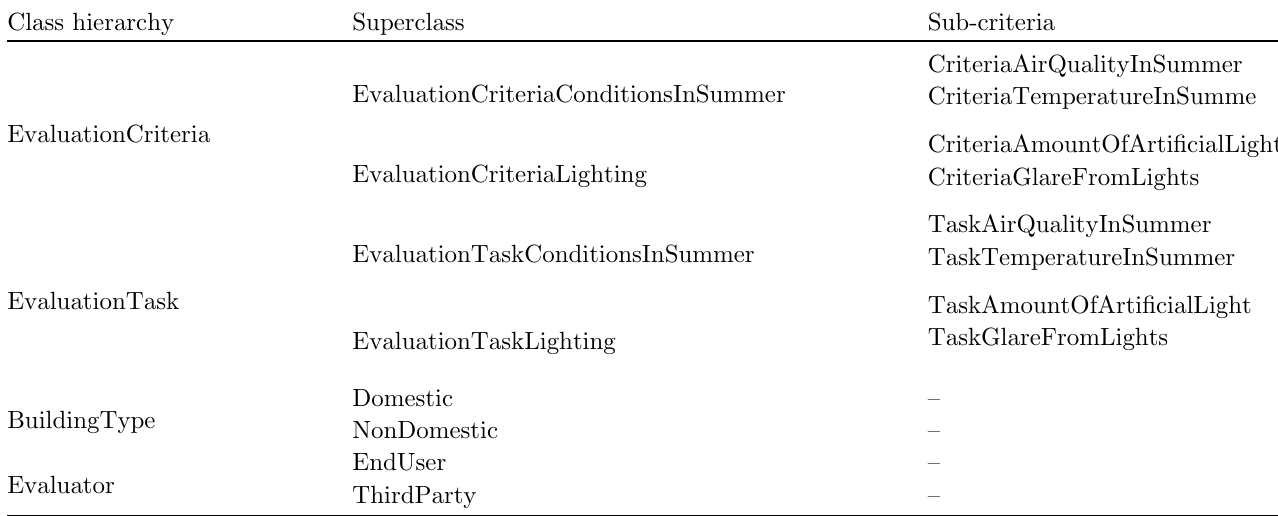
Fig. 2. The ‘ Seven-Step ’ method of ontology development. Table 2. The class hierarchies of some ontology